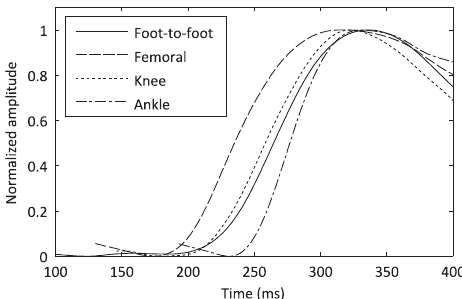
Fig.6: Foot-to-foot IPG and local IPG at the femoral artery, knee, and the